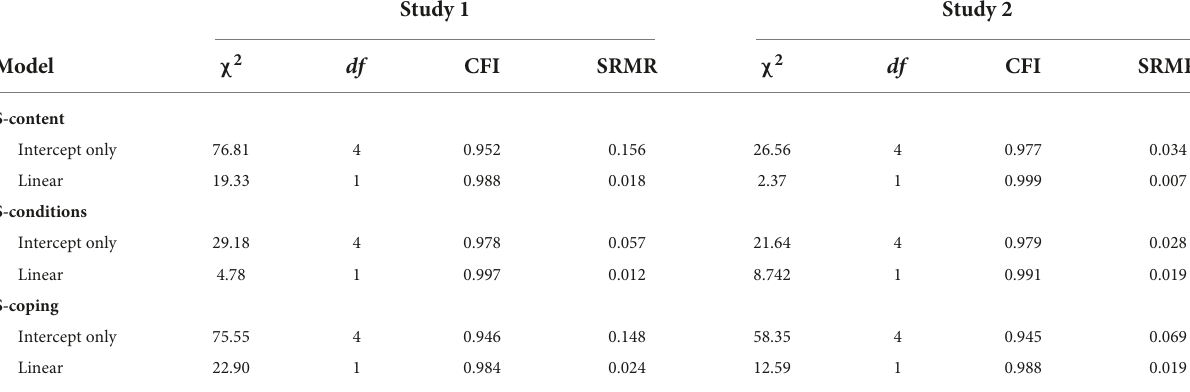
TABLE 2 Fit statistics for intercept-only models and linear unconditional first-order latent growth curve models. Study 1 Study